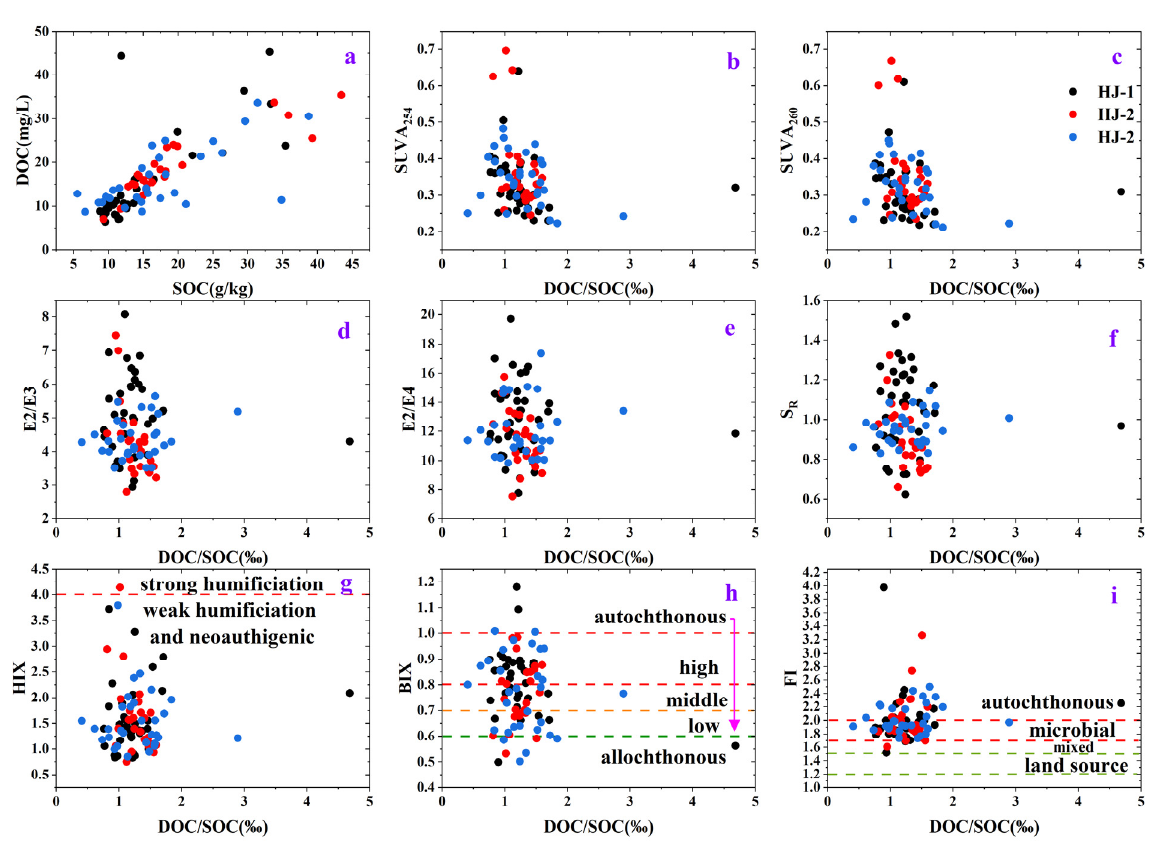
Figure A1. Scatter plots of SUVA 254 ( b ), SUVA 260 ( c ), E2/E3 ( d ), E2/E4 ( e ), FI ( i ), S R ( f ), HIX ( g ), and BIX ( h ) with DOC/SOC (‰) as the x -axis, and DOC ( a ) along SOC. SUVA 254 and SUVA 260 in L · mg C − 1 ·m − 1 .